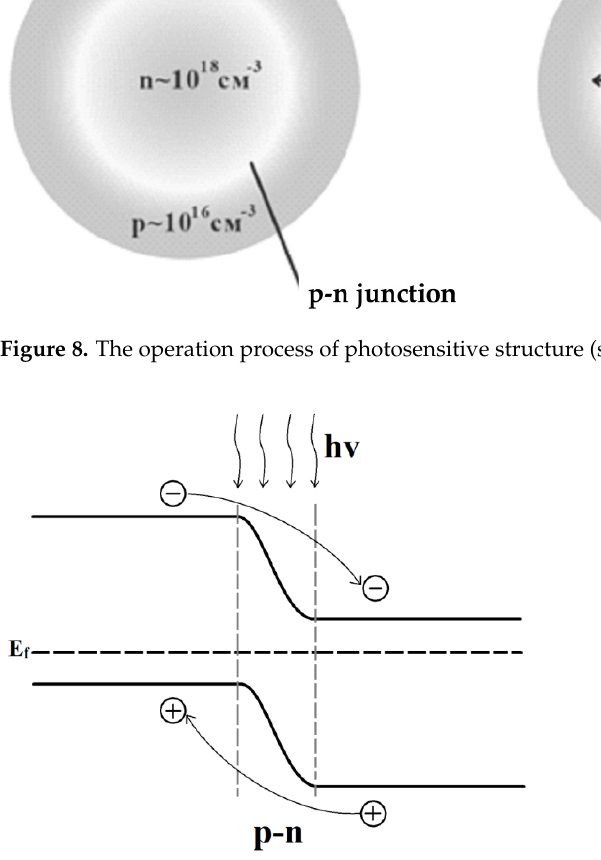
Figure 9. Energy diagram of the p–n junction region in photosensitive structure under illumination.